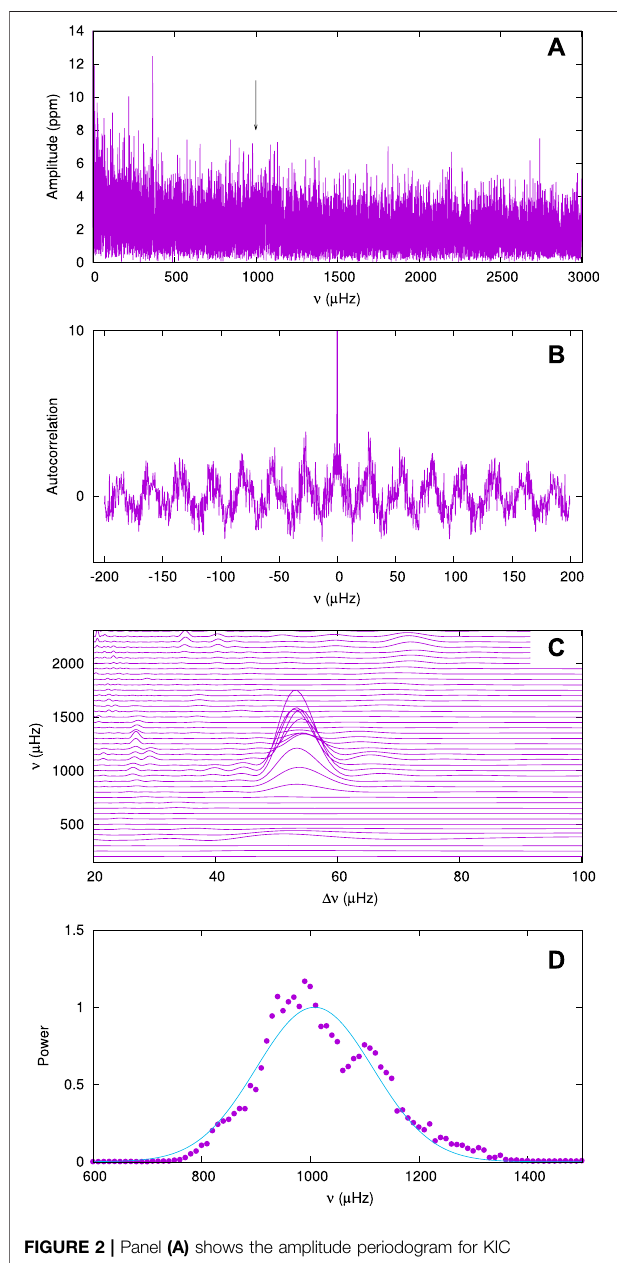
FIGURE 2 | Panel (A) shows the amplitude periodogram for KIC 3219634, the arrow indicating ] max . Panel (B) shows the autocorrelation at a frequency of 1,000 μ Hz showing a period of about ( 1 / 2 ) Δ ] ≈ 27 μ Hz. Panel (C) shows power spectra of the autocorrelation (after removing the central peak) plotted against frequency (the ] – Δ ] diagram). Panel (D) shows the maximum autocorrelation power as a function of frequency within a 10% rangeoftheapproximate Δ ] .Thecurveisa fi ttedGaussianwithamaximumat ] (cid:2) 1 , 008 . 1 ± 2 . 8 μ Hz. The average Δ ] within ± ( 1 / 2 ) FWHM of the max maximum is 54 . 06 ± 0 . 18 μ